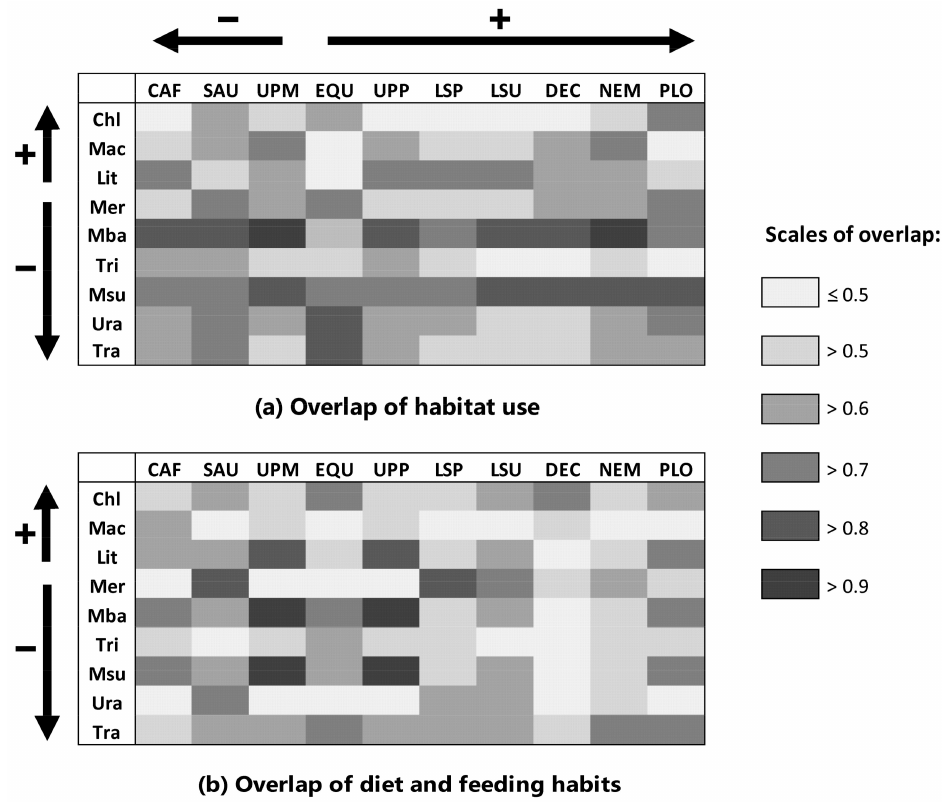
Figure 2. Overlap in habitat use and diet related traits between native and non-indigenous species. Only benthic and bentho-pelagic fishes are included. ( a ) Habitat use including the depth-range distribution based on the Bray-Curtis index; ( b ) diet-related traits based on the Morisita-Horn index. Abbreviations (capitals are used for non-indigenous species): CAF, Callionymus filamentosus ; Chl, Chlorophthalmus agassizi ; DEC, Decapterus russelli ; EQU, Equulites klunzingeri ; Lit, Lithognathus mormyrus ; LSP, Lagocephalus spadiceus ; LSU, Lagocephalus suezensis ; Mac, Macroramphosus scolopax ; Mer, Merluccius merluccius ; Mba, Mullus barbatus ; Msu, Mullus surmuletus ; NEM, Nemipterus randalli ; PLO, Plotosus lineatus ; SAU, Saurida lessepsianus ; Tra, Trachinus draco ; Tri, Trigla lyra ; UPM, Upeneus moluccensis ; UPP, Upeneus pori ; Ura, Uranoscopus scaber. Arrows and +/ − indicate increasing positive/negative population trends of